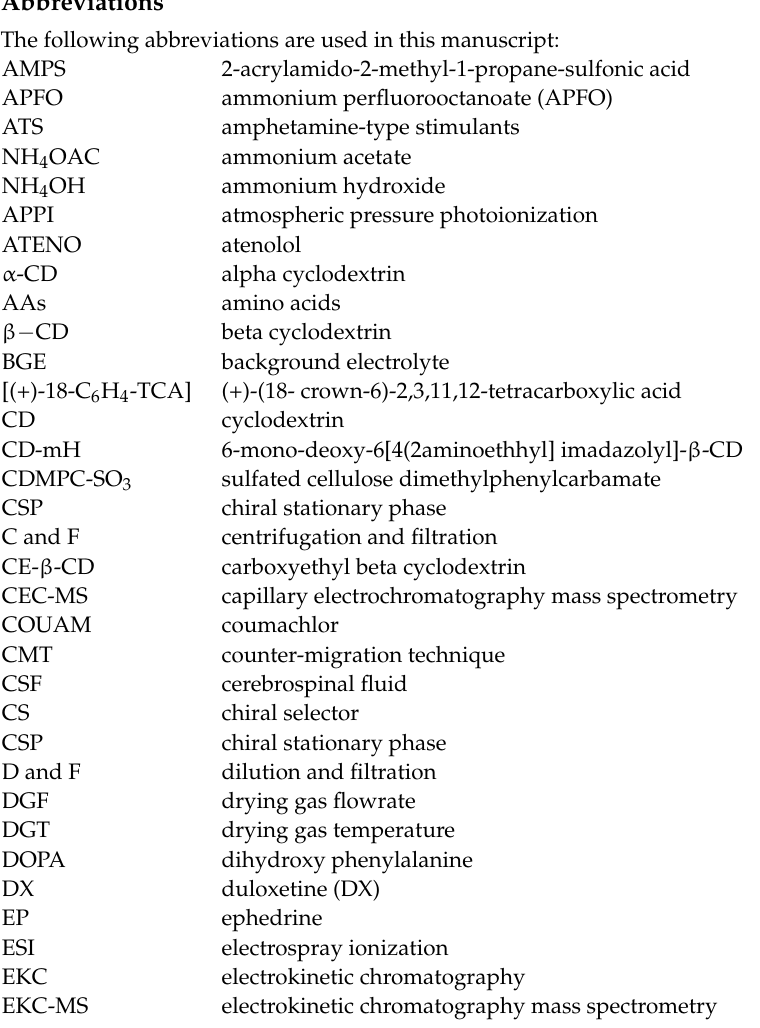
strategy, Figure S2: A horizontal bar chart showing journals publishing chiral CE-MS articles over the past 10 years (2010–2020), Figure S3: A pictorial representation of (A) Agilent co-axial sheath liquid CEMS interface, (B) sheathless porous tip interface [65], Figure S4: Schematic of the CE-APPI-MS [66], Figure S5: Schematic diagram of the interface for coupling capillary electrophoresis (CE) with ICP- MS [67], Figure S6: (a) Schematics of partial filling technique in chiral CE-MS using a non-volatile surfactant [68], and (b) schematic representation of the CMT [27], Figure S7: Comparison of (A) low-molecular-mass monomeric (unpolymerized) micelles and (B) high-molecular-mass micelle polymer introduced to ESI-MS